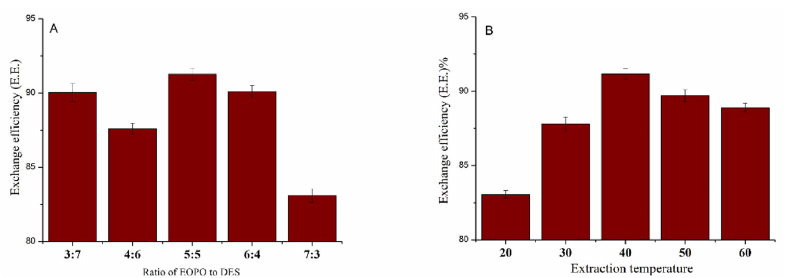
Figure 3. Optimized extraction process for ATPS extraction (exchange efficiency at different ratios of EOPO to DES ( A ), and extraction temperatures ( B